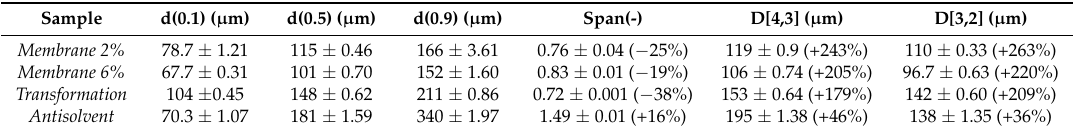
Table 2. Malvern Mastersizer data for the crystals at the end of the seeded experiments, where d(0.1), d(0.5), and d(0.9) are the particle diameters at 10%, 50% and 90% of the cumulative distribution, Span was calculated as [d(0.9) − d(0.1)]/d(0.5), and D[4,3] and D[3,2] are the volume and surface weighted mean diameters, respectively. The table shows the average values of all the measurement replicates and corresponding standard deviations.